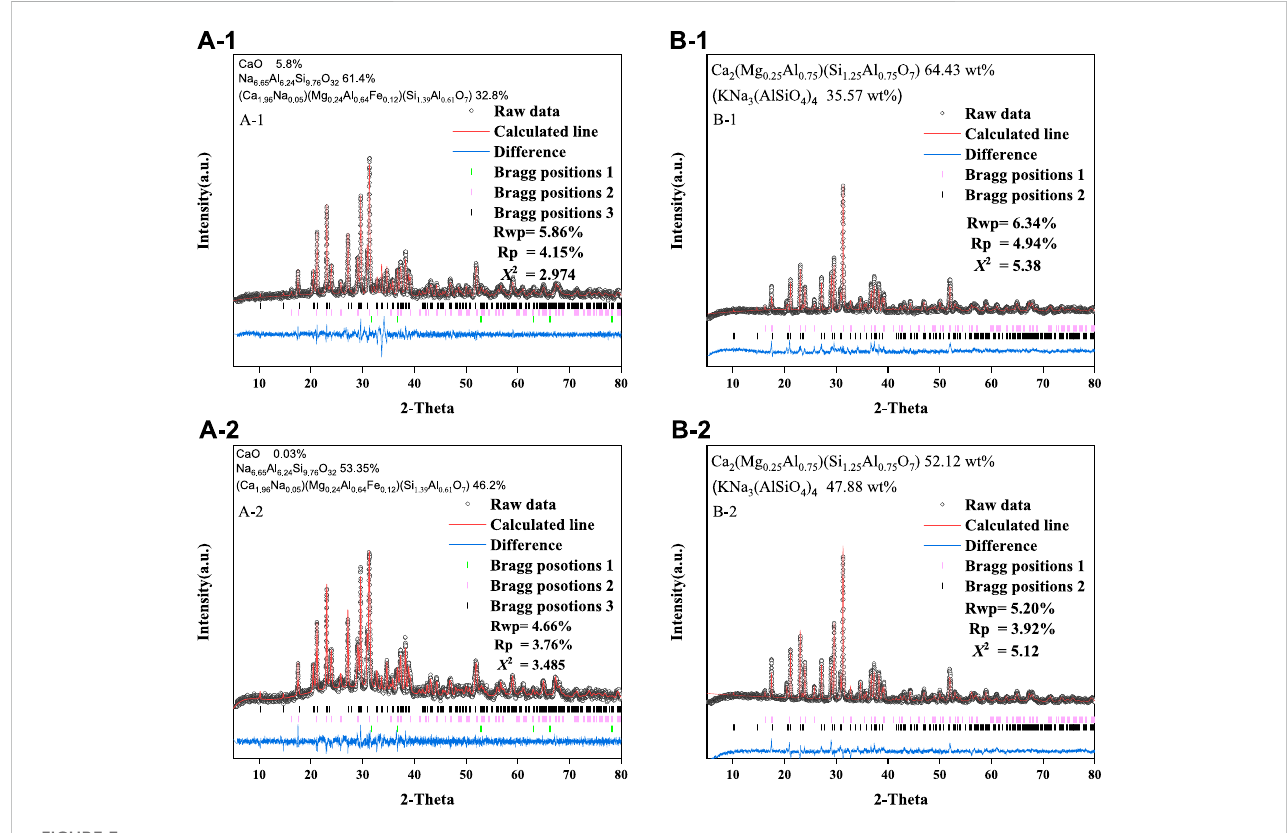
FIGURE 3 Rietveld re fi nement analysis of the XRD patterns for A-1 and B-1 at 850 ° C, and A-2 and B-2 at 1,050 ° C. For A-1 and A-2: Bragg position 1 is CaO; Bragg position 2 is KNa 3 (AlSiO 4 ) 4 ; Bragg position 3 is Ca 2 (Mg 0.25 AI 0.75 ) (Si 1.25 AI 0.75 O 7 ). For B-1 and B-2: Bragg position 1 is Na 6.65 Al 6.24 Si 9.76 O 32 ; Bragg position 2 is